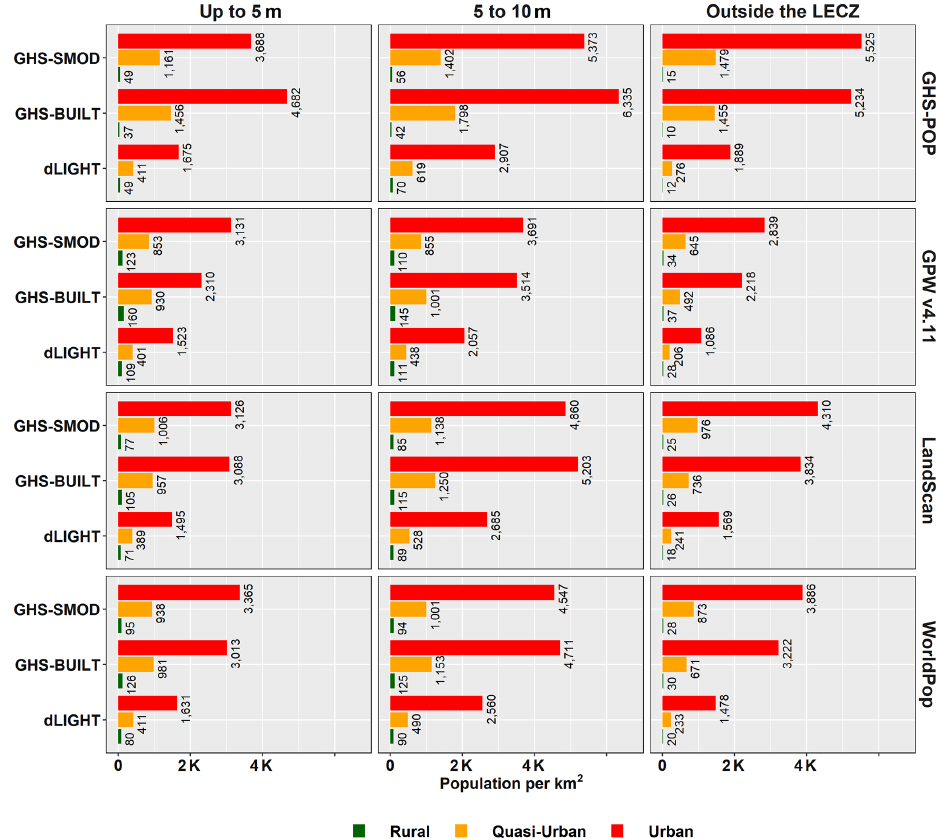
Figure B4. Population density of urban, quasi-urban and rural by urban–rural classes, by LECZ using MERIT DEM.